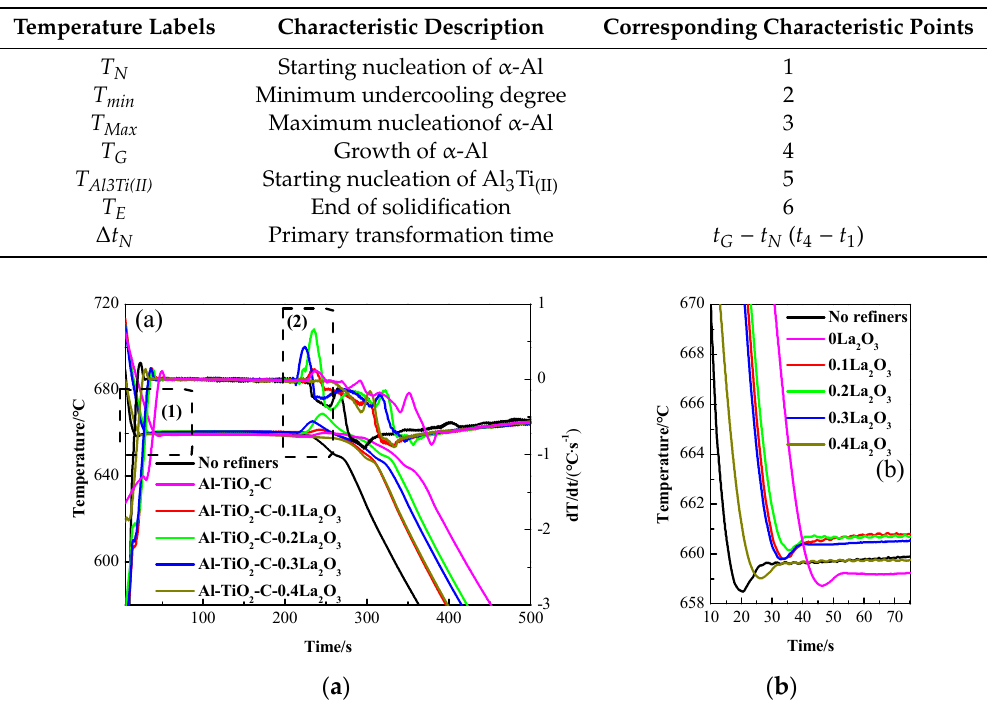
Table 4. List of characteristic parameters.